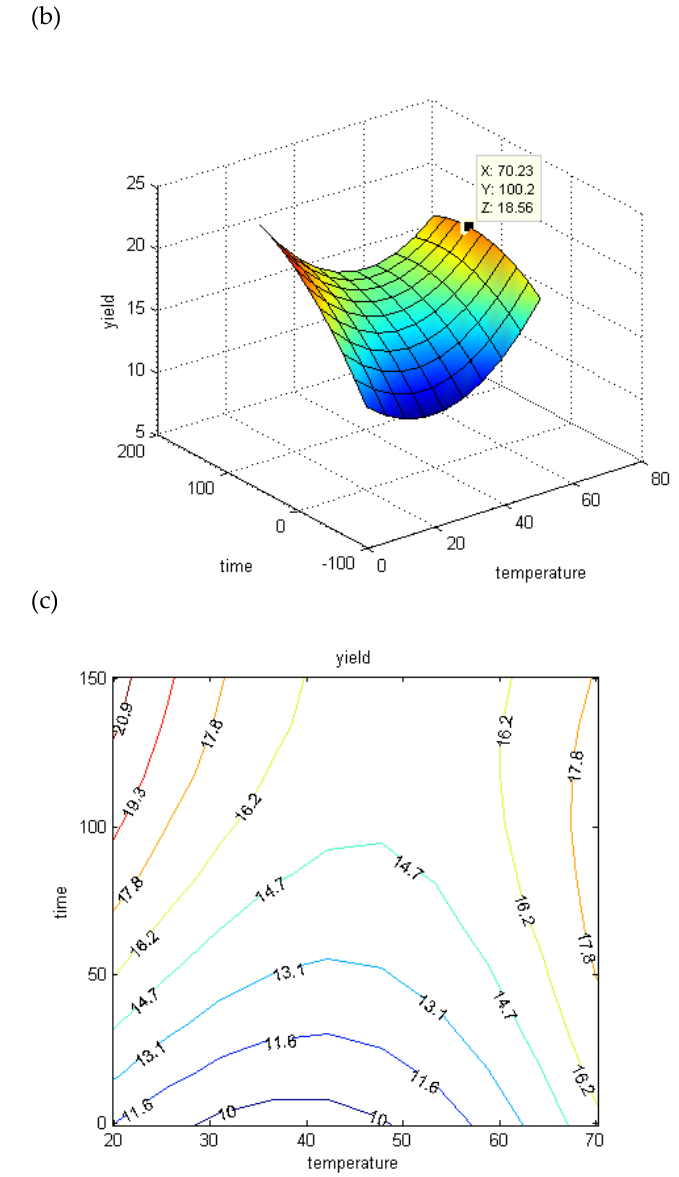
Figure 3. Optimization of CBP extraction. ( a ) Pareto chart graphically describing the size of the effect of each variable or their interaction on CBP extraction yield. The vertical line indicated the significance of each effect ( p = 0.05). ( b ) Three-dimensional response surface plot (X—temperature, Y—time, X—yield) and ( c ) contour plot for the interactive effects of extraction temperature (X1), time (X2), and solvent to raw material ratio (X3), set at 10 in CBP extraction system.